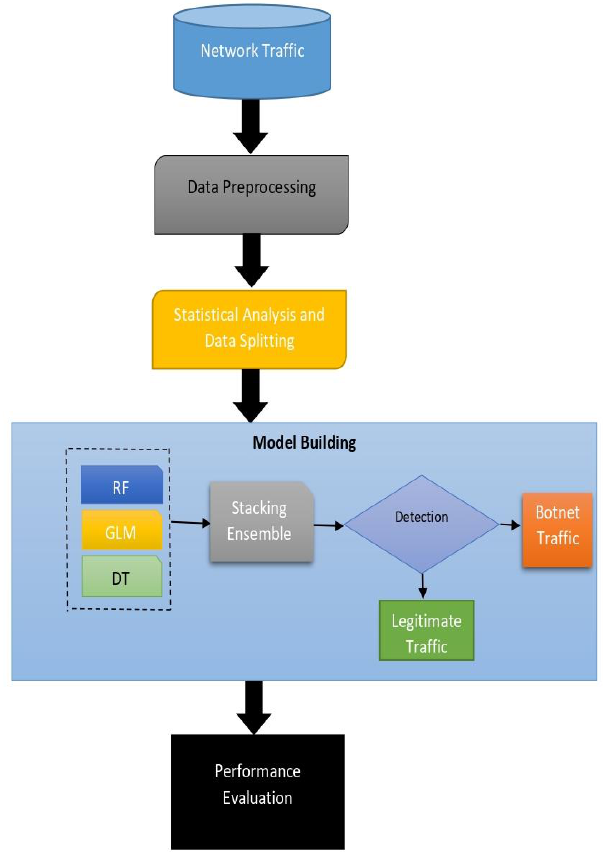
Figure 1. The modeling framework of the